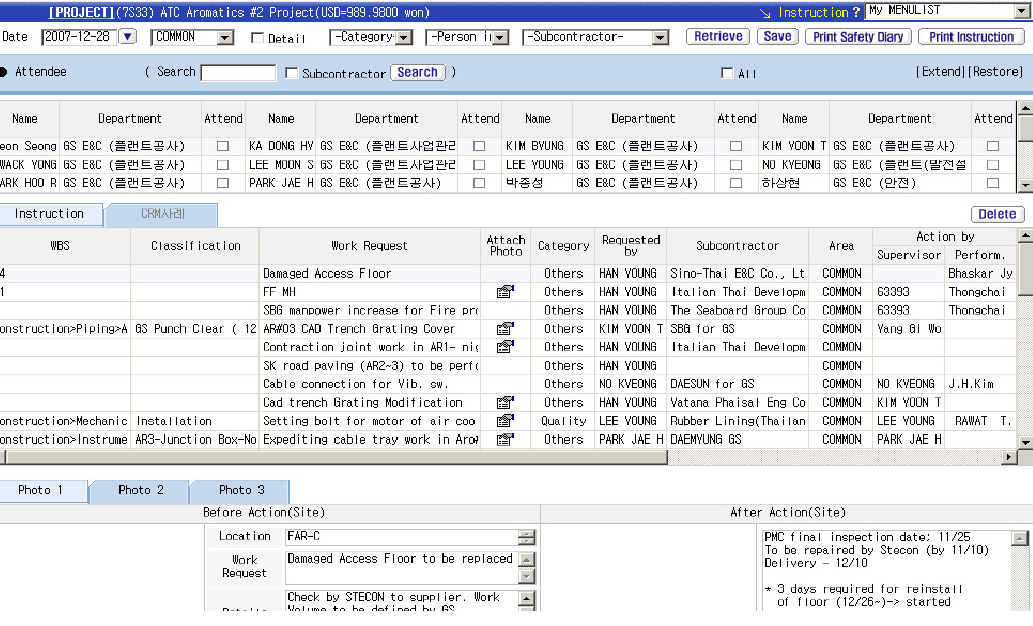
Fig. 7. Work order